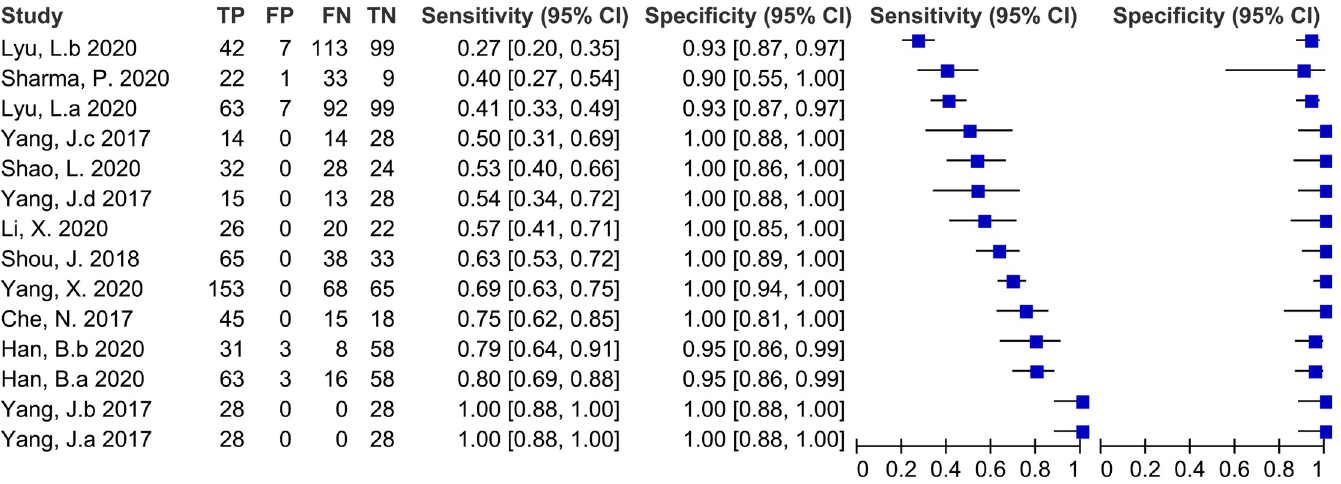
PLOS ONE | https://doi.org/10.1371/journal.pone.0253658 June 23,